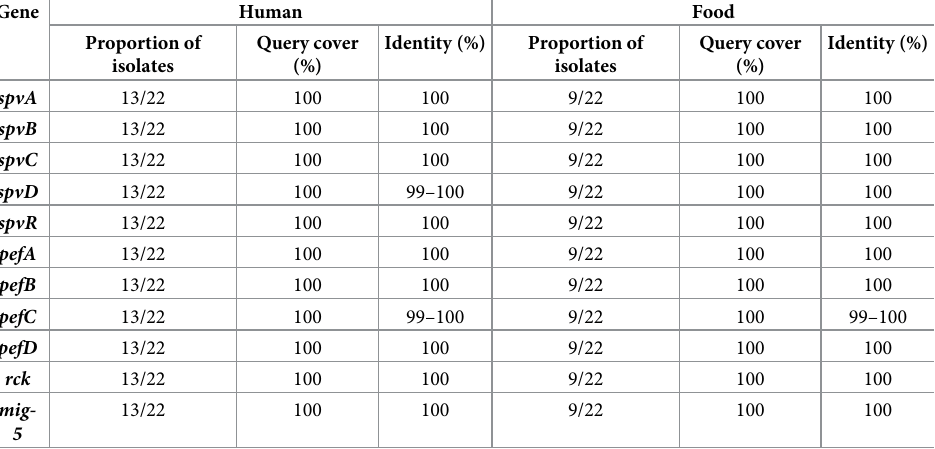
Table 3. Characteristics of the plasmid genes presented in 22 Salmonella Typhimurium isolates by Virulence fac- tors database (VFDB).